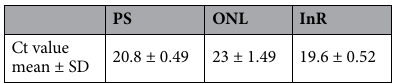
Table 2. Real-time PCR for Actb in PS, ONL, and InR.